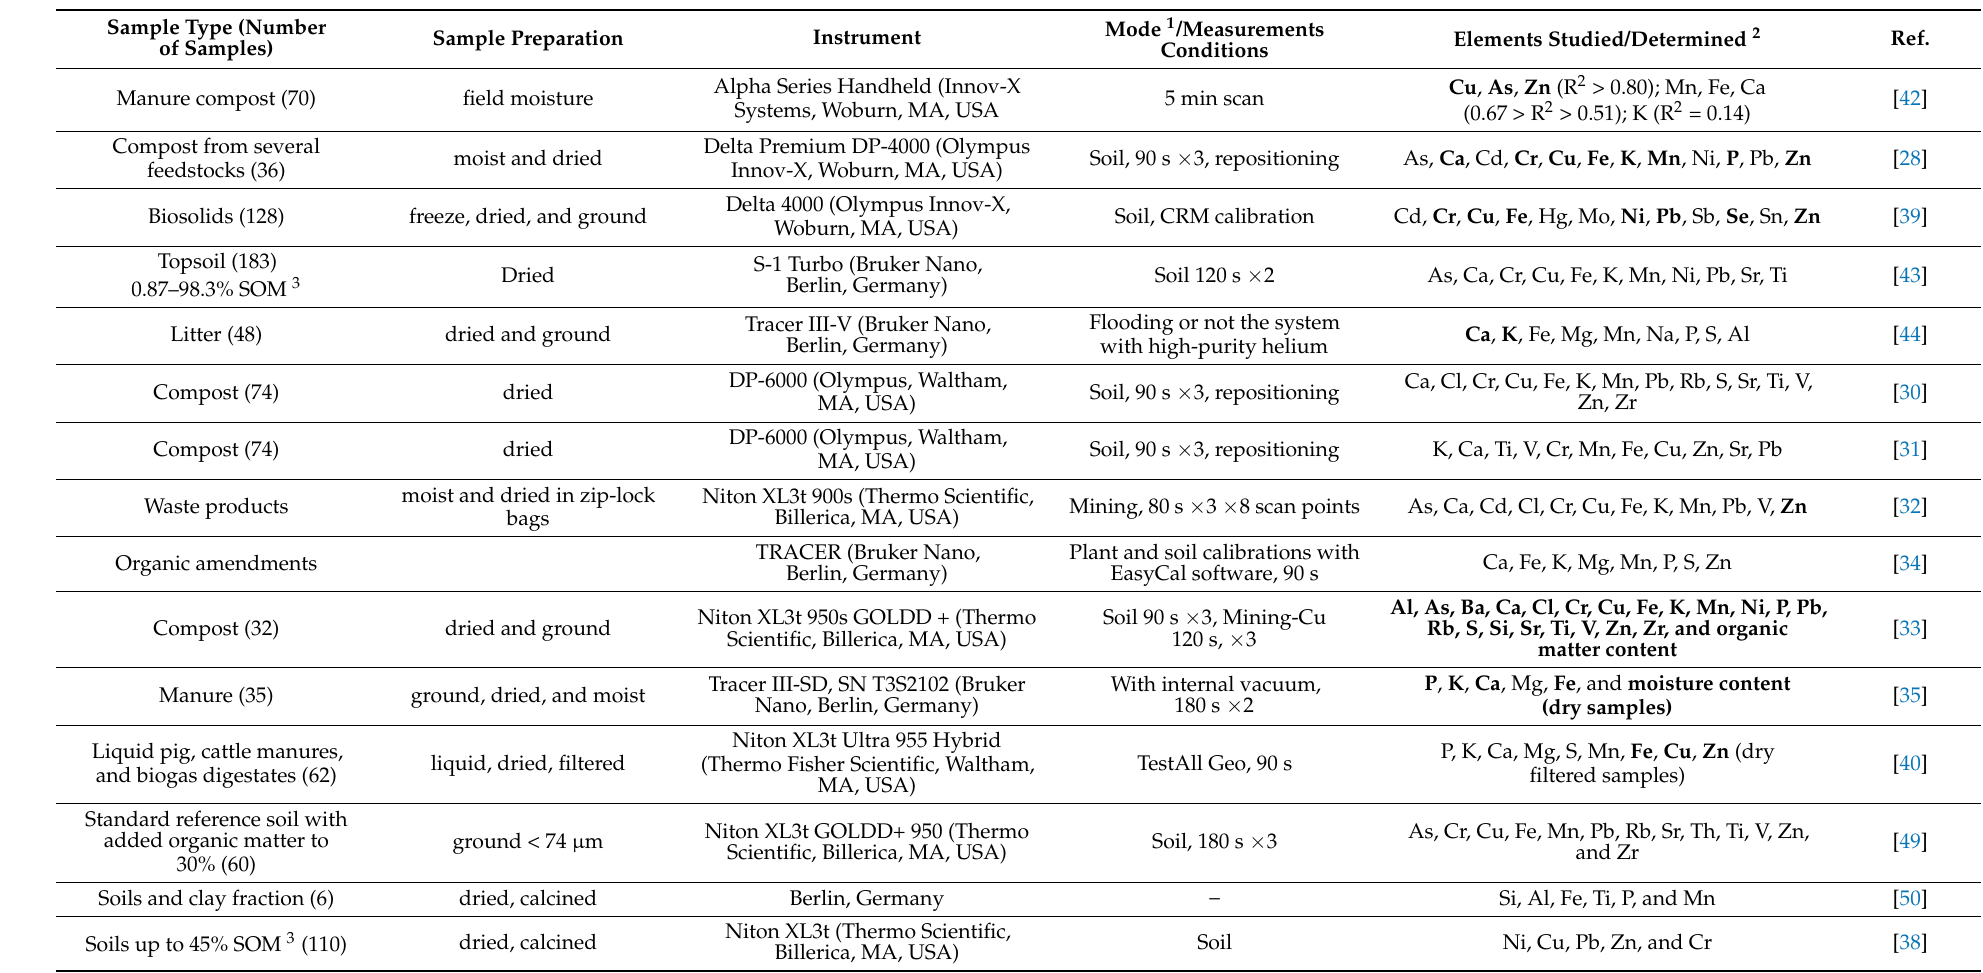
Table 2. Details of the studies that make use of pXRF in organic amendments and soils rich in organic